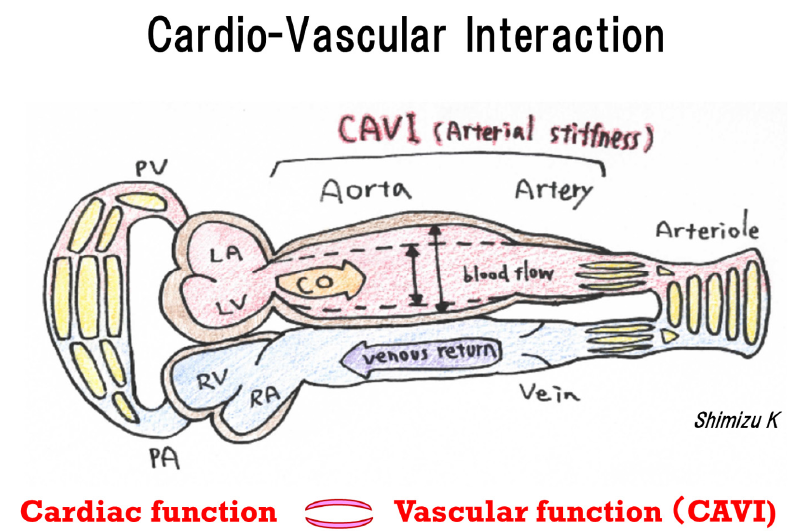
Figure 3. Cardiovascular interaction. Systemic circulation is pumped by the left ventricle but supported by the right ventricle. The left ventricle and all vessels are composed of the aorta, muscular artery, arteriole, and vein. Each artery has its own function. CAVI reflects vascular function of the aorta and muscle. Study Limitations